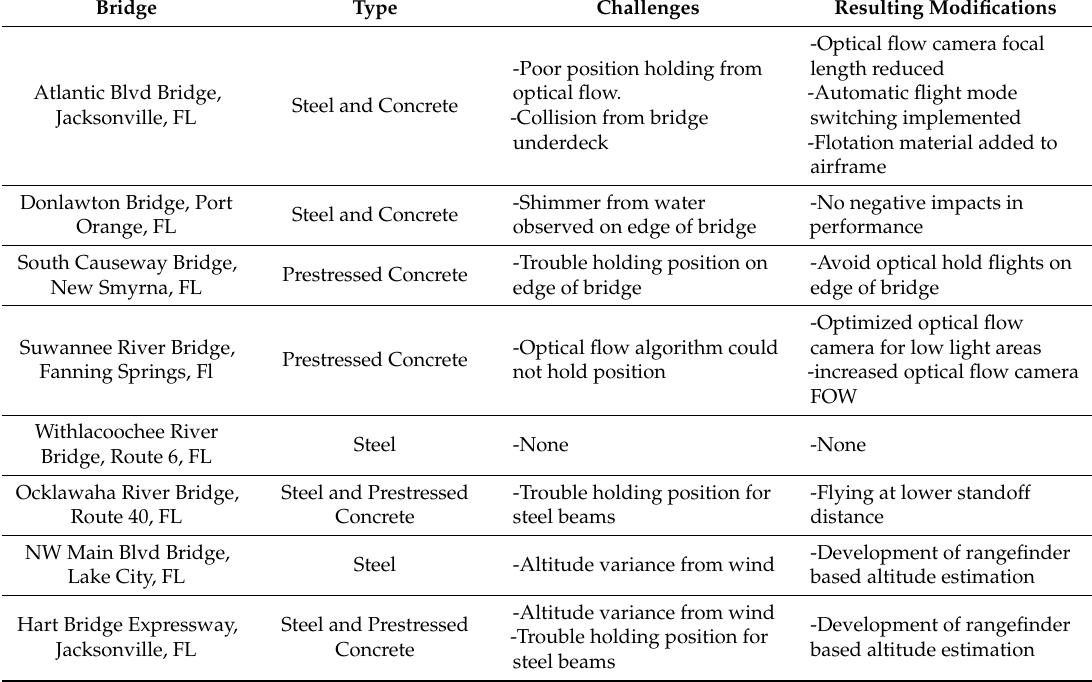
Table 1. Summary of bridges inspected alongside Florida Department of Transportation and modifications as a result of